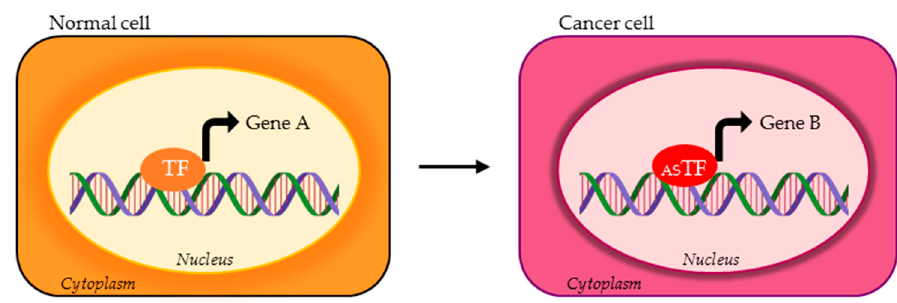
Figure 1. Possible activity of transcription factor (TF) alternative splicing (AS) isoforms in normal vs. cancer cells. The TF variant expressed in cancer cells (red ASTF) can bind and transcriptionally regulate different set of genes compared to the TF physiologically expressed in normal cells (orange TF). Gene A and gene B represent two different targets of TF isoforms.